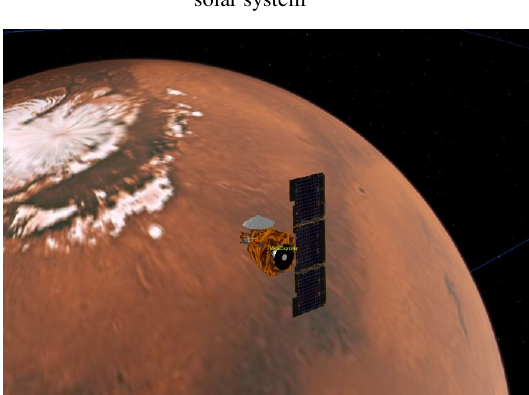
Figure 5b. Modeling and Visualization of deep space